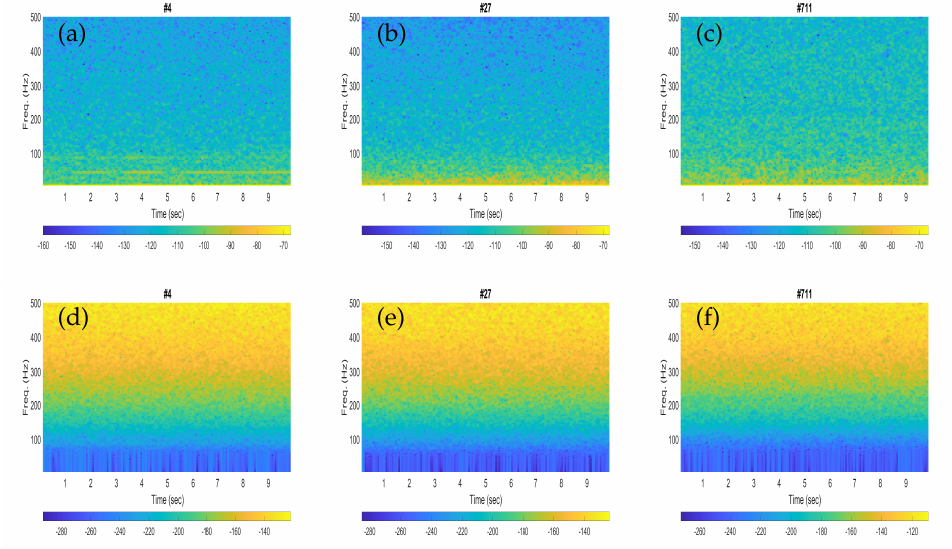
Figure 3. Illustrative spectrogram plots for the noisy signals with fin whale calls ( a – c )) and the corresponding noise-only signals ( d – f